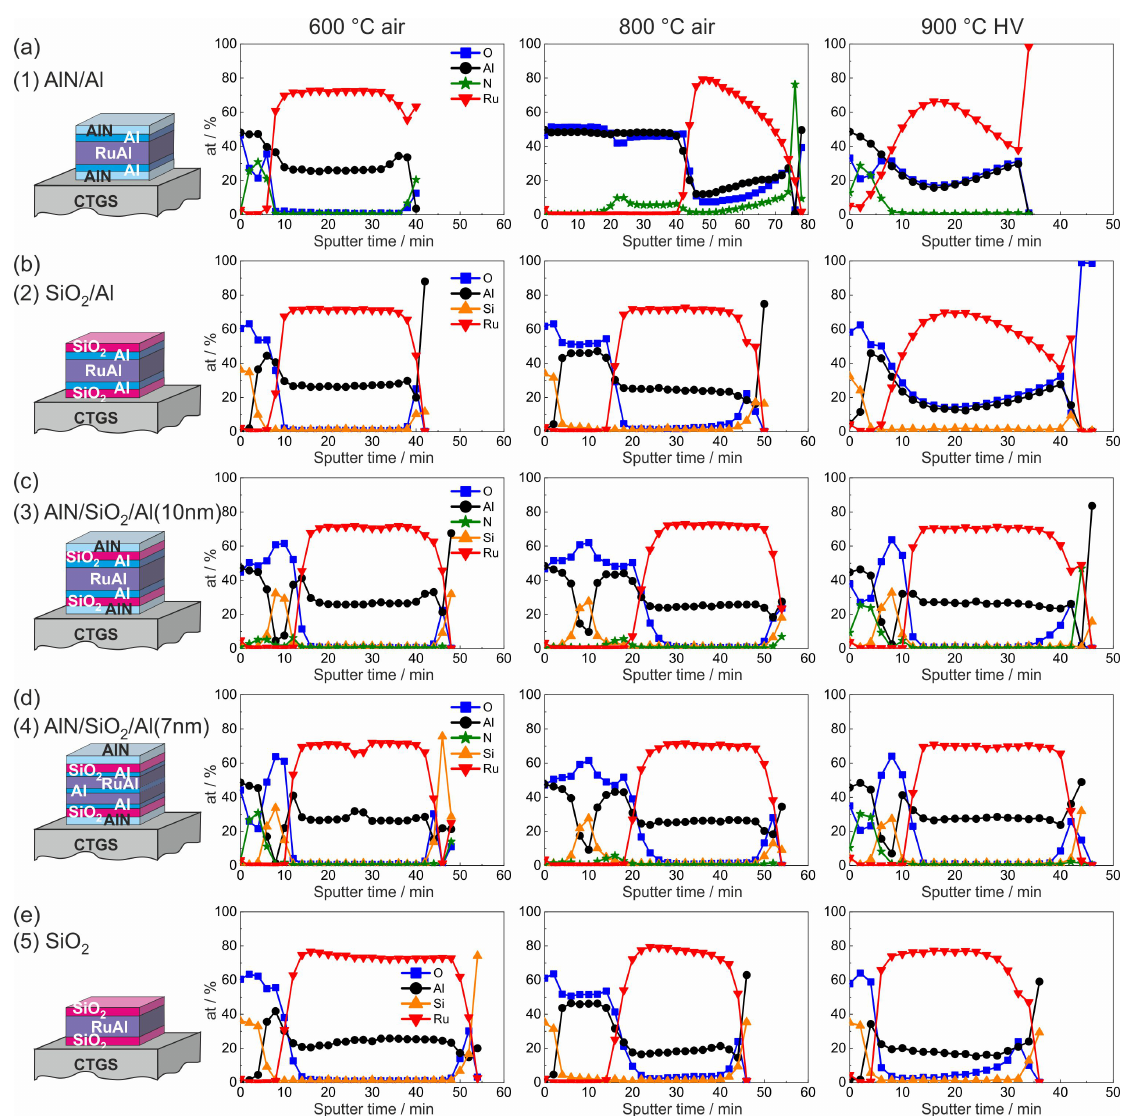
Figure 10. Results of the AES measurements for the samples with the different cover and barrier layers on CTGS substrates after annealing at 600 and 800 ◦ C in air and 900 ◦ C in HV: ( a ) (1)-AlN/Al, ( b ) (2)-SiO 2 /Al, ( c ) (3)-AlN/SiO 2 /Al(10 nm), ( d ) (4)-AlN/SiO 2 /Al(7 nm), and ( e ) (5)-SiO 2